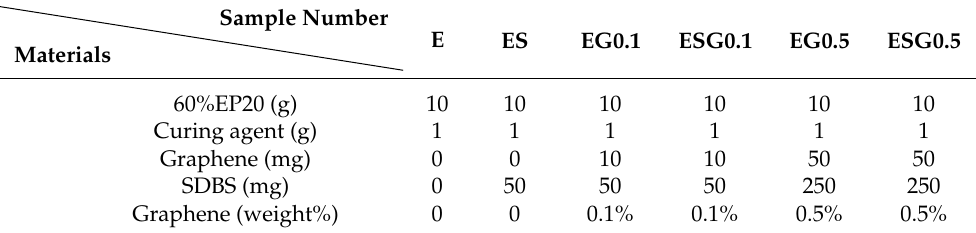
Table 2. Composition of graphene-modified epoxy resin